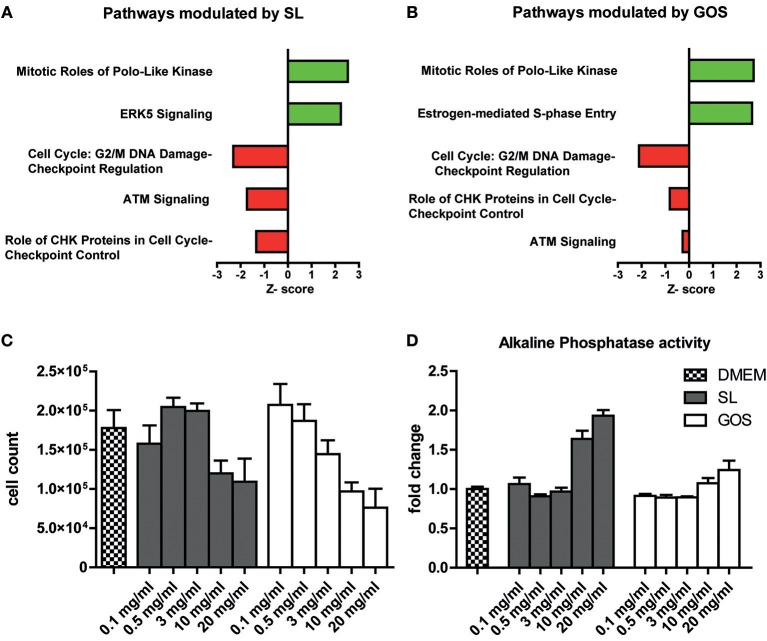
SL and GOS modulate cell proliferation and induce differentiation. A fully polarized epithelial layer of Caco-2 cells cultured in DMEM +10% FCS was exposed to 10 mg/ml SL or GOS for 6 h. After 6 h the cells were lysed and RNA was isolated for microarray analysis and subsequent IPA analysis. The top five most significantly, excluding ERK5 (p = 0.07), regulated pathways by (A) SL and (B) GOS (IPA analysis results) were shown. Next, phenotypic changes were assessed by culturing Caco-2 cells for 4 days in the presence of different concentrations of GOS and SL (0.1–20 mg/ml), followed by (C) cell counting by flow cytometry (n = 2) and (D) alkaline phosphatase activity determination in culture supernatants (n = 4). Data was represented as mean ± SEM.